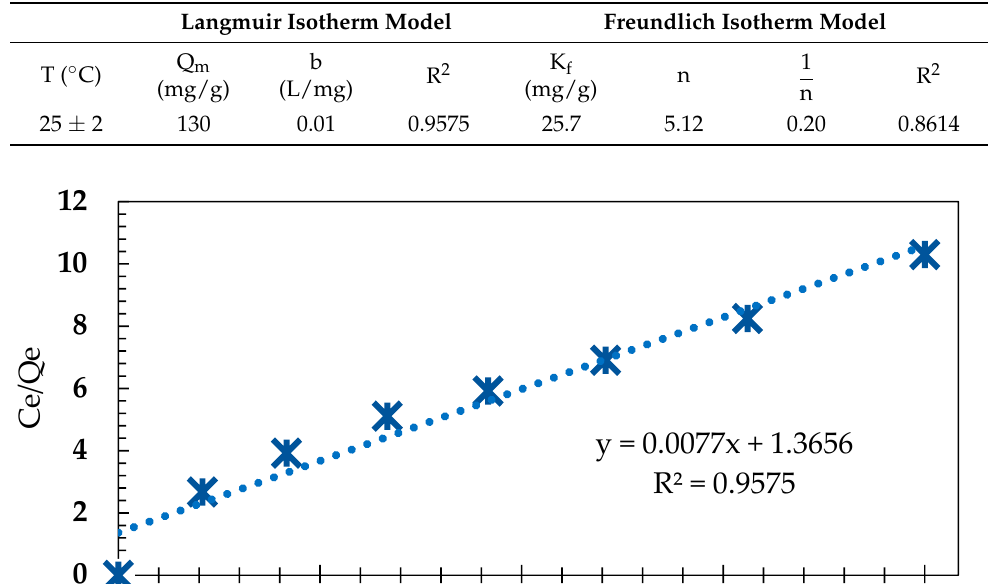
Table 3. Langmuir and Freundlich parameters for AB 113 adsorption onto IRA 402 mass